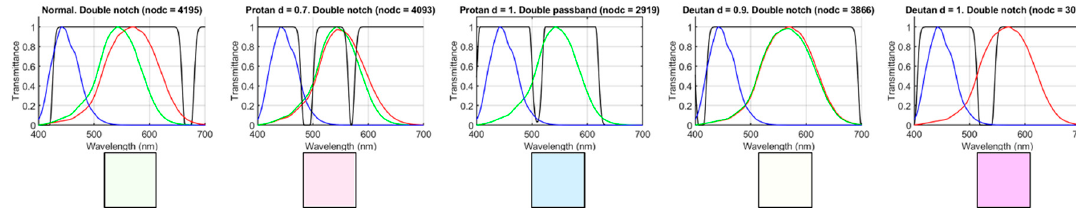
Figure5. SpectraltransmittancesofthefiltersthatmaximizetheNODCforeachtypeofobserverstudied. Figure 5. Spectral transmittances of the filters that maximize the NODC for each type of observer studied. For all observers, it should be noted that there were more filters that produced an increase in the